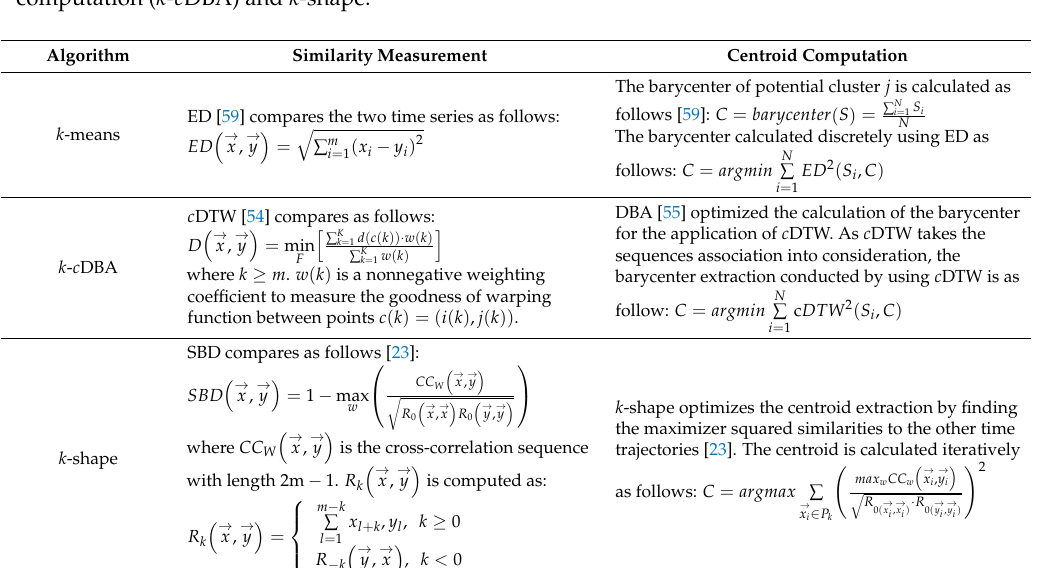
Table 2. The comparison of similarity measurement and centroid computation approaches among k -means, time series clustering algorithm with c DTW as the distance measure, and DBA for centroid computation ( k - c DBA) and k